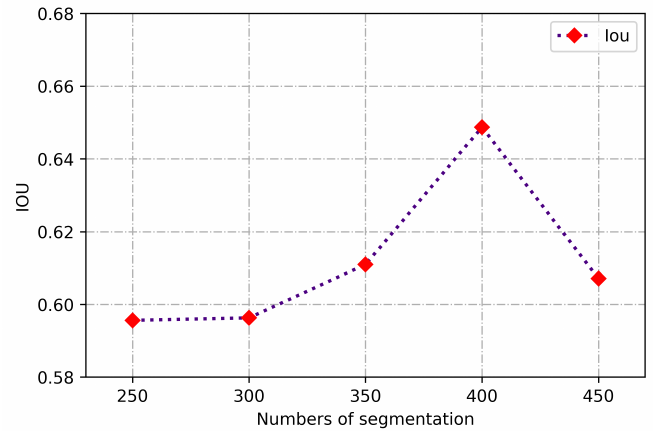
Figure 7. Curve of the merged IOU and the initial number of